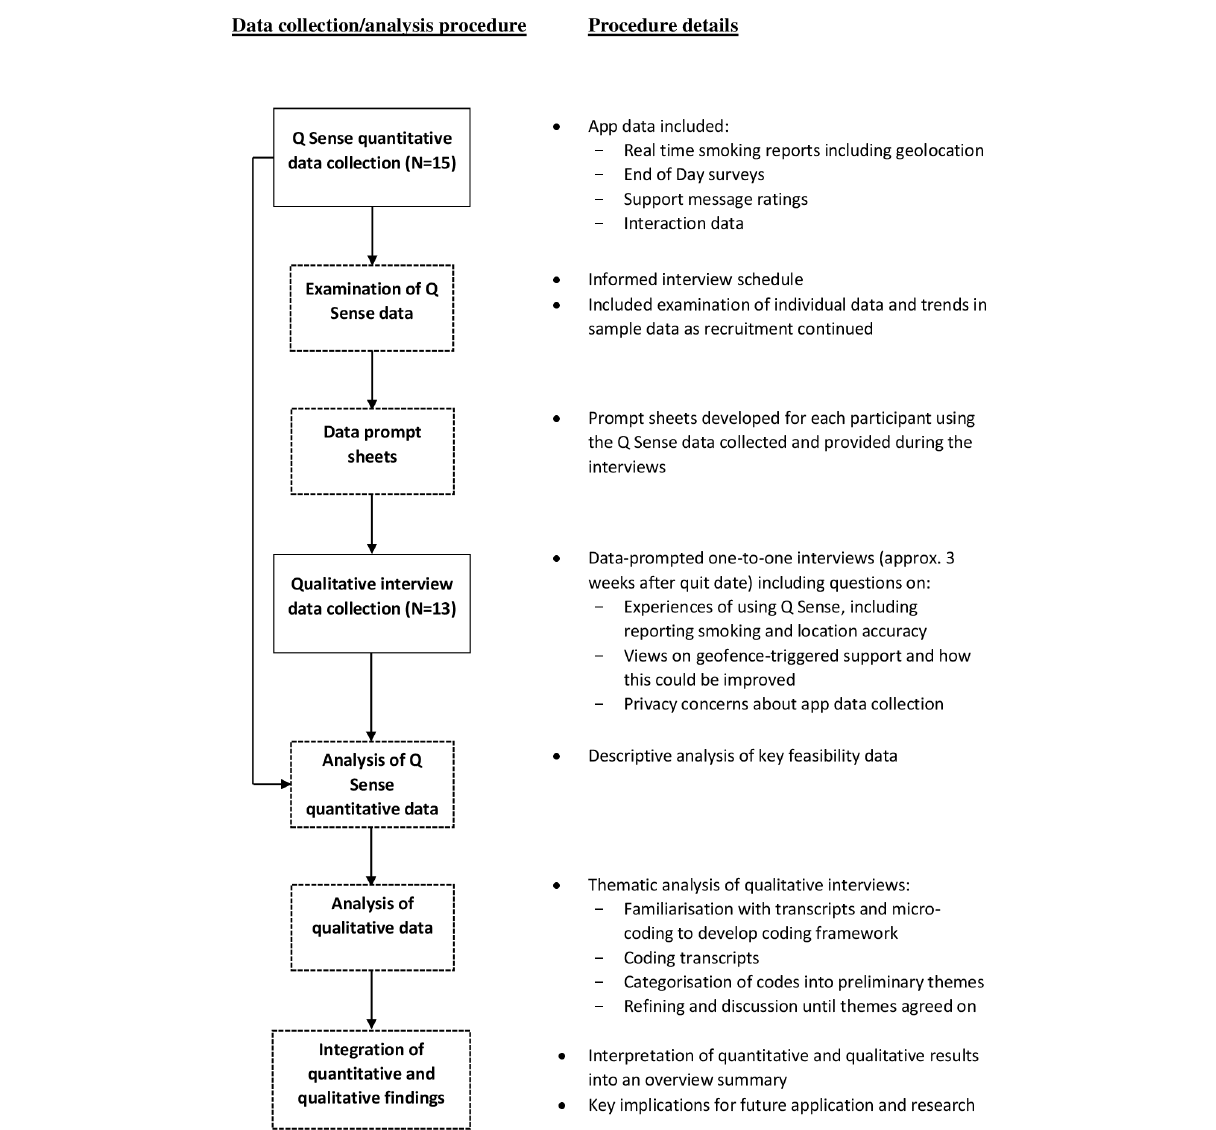
Figure 1. Procedural diagram of the explanatory sequential mixed-methods design